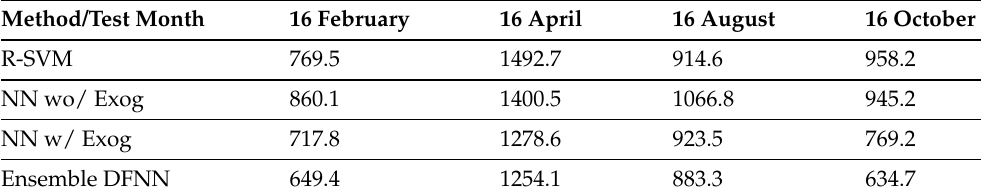
Table 4. Comparison of one day-ahead NE Load Forecasting results: RMSE (MW).